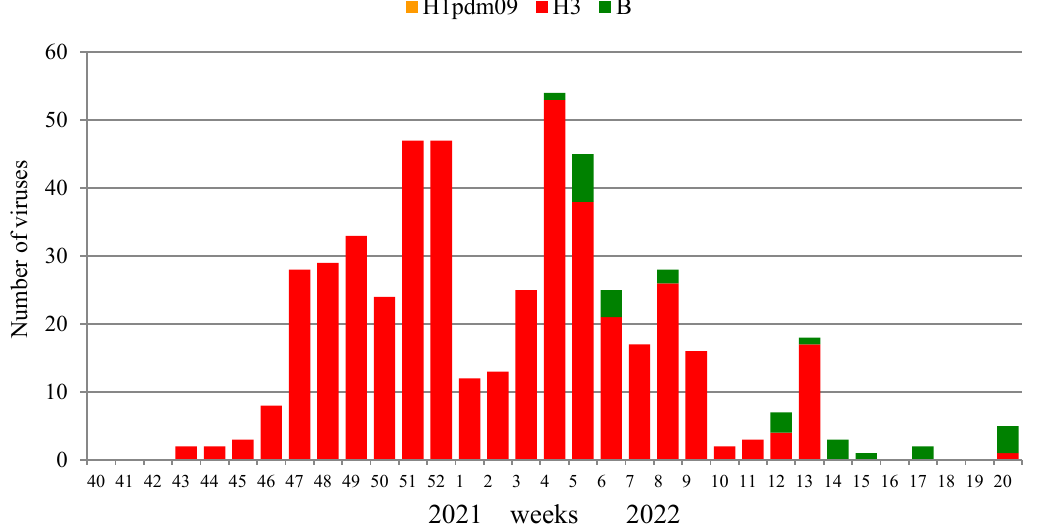
Figure 7. Monitoring of influenza virus isolation in two NICs and collaborating RBLs, season 2021– 2022.